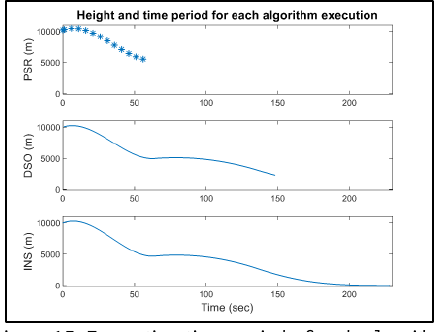
Figure 15. Execution time period of each algorithm